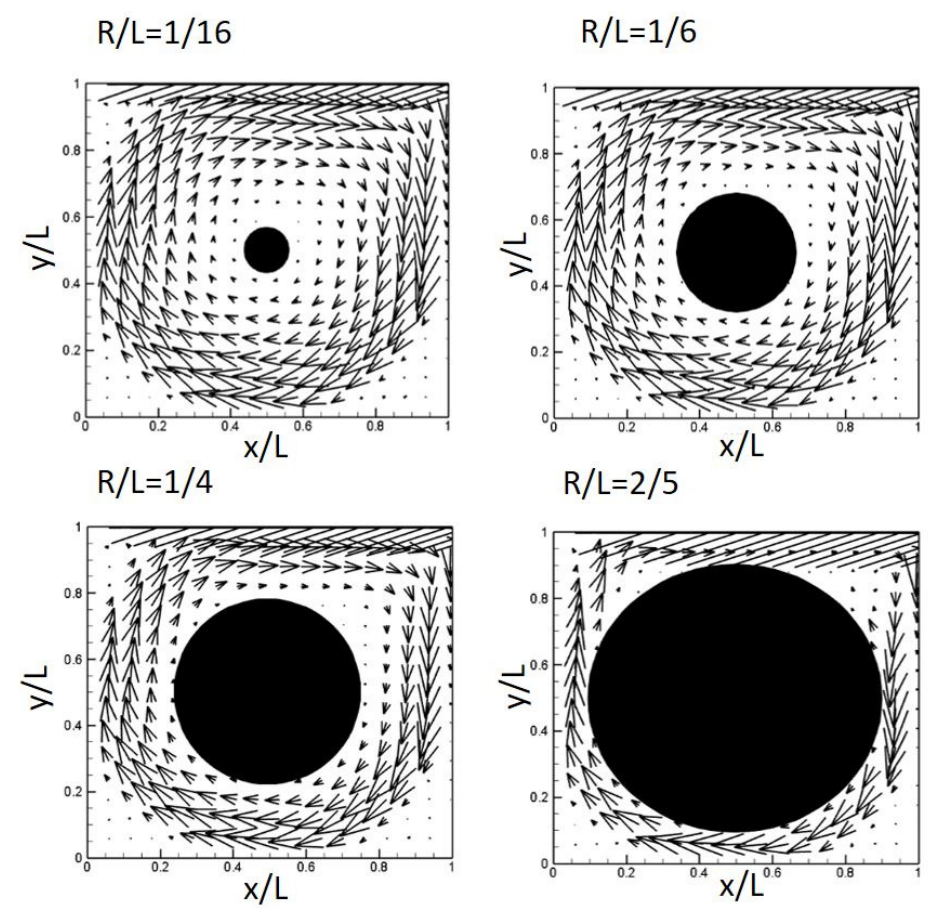
Figure 17. Vector profiles for obstacles of various sizes.